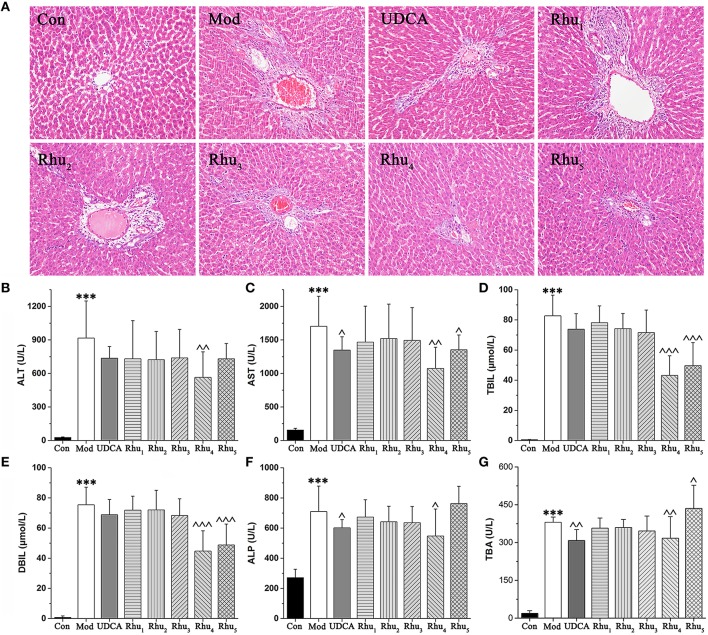
(A) Typical histopathological section photographs of rat liver specimens for H&E analysis (200 × magnification). (B–G) Shown are the serum ALT, AST, TBIL, DBIL, ALP and TBA levels, respectively. ALT, alanine aminotransferase; AST, aspartate aminotransferase; TBIL, serum total bilirubin; DBIL, serum direct bilirubin; ALP, alkaline phosphatase; TBA, total bile acid. ANOVA with the post hoc test was used to calculate the significance of the differences, *** represents p < 0.01 compared with the control group, ^, ^^, and ^^^ represent p < 0.05, p < 0.01 and p < 0.001 compared with the model group, respectively.